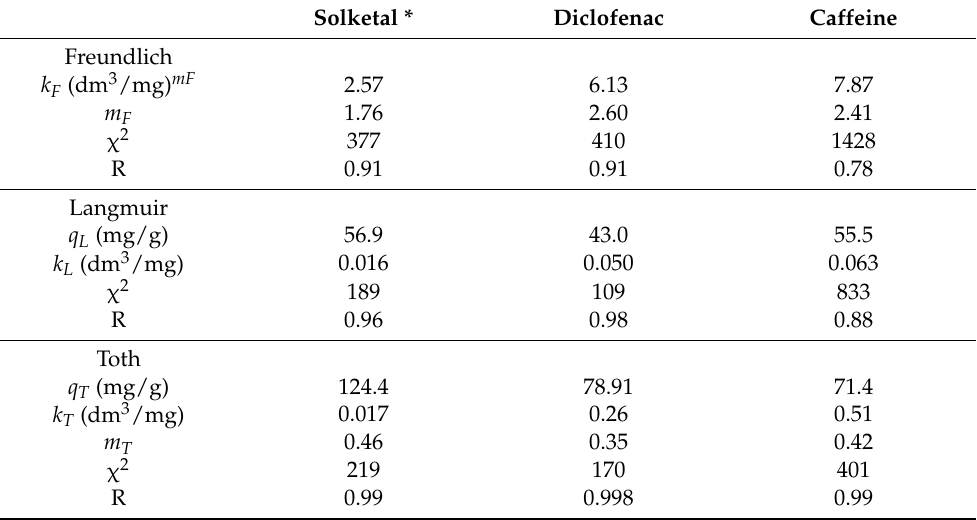
Table 3. Freundlich, Langmuir, and Toth parameters for adsorption by the MOF. Equilibrium time = 7 h, T= 298